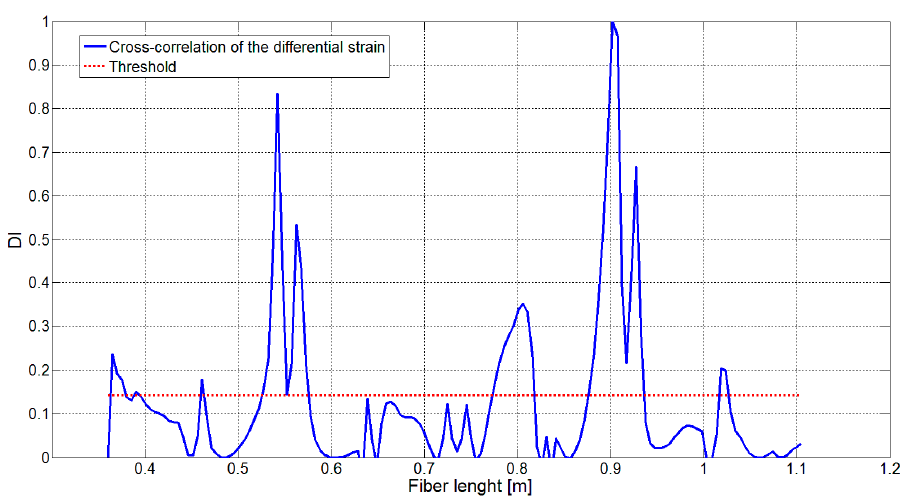
Figure 14. Damage index and threshold level (red line) estimated from the DI.